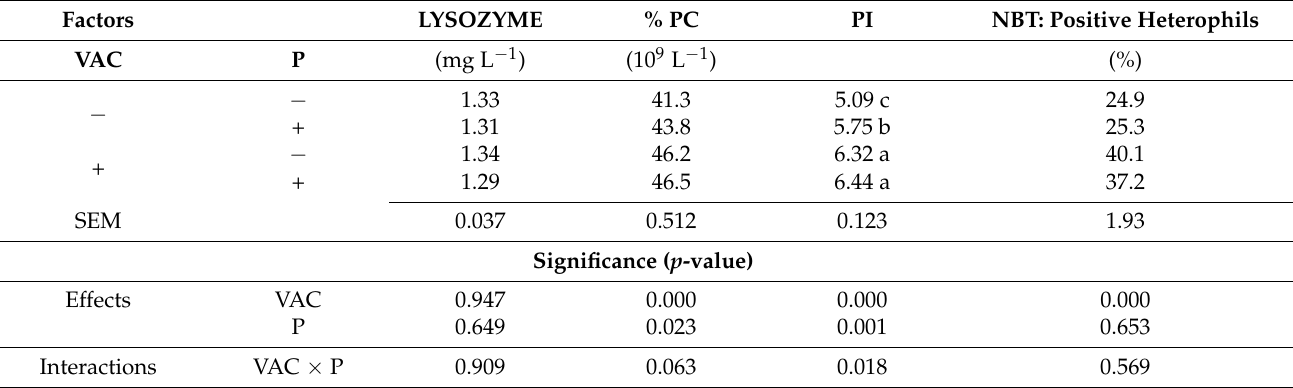
Table 4. Immunological indices of chicken blood collected at 16 d of